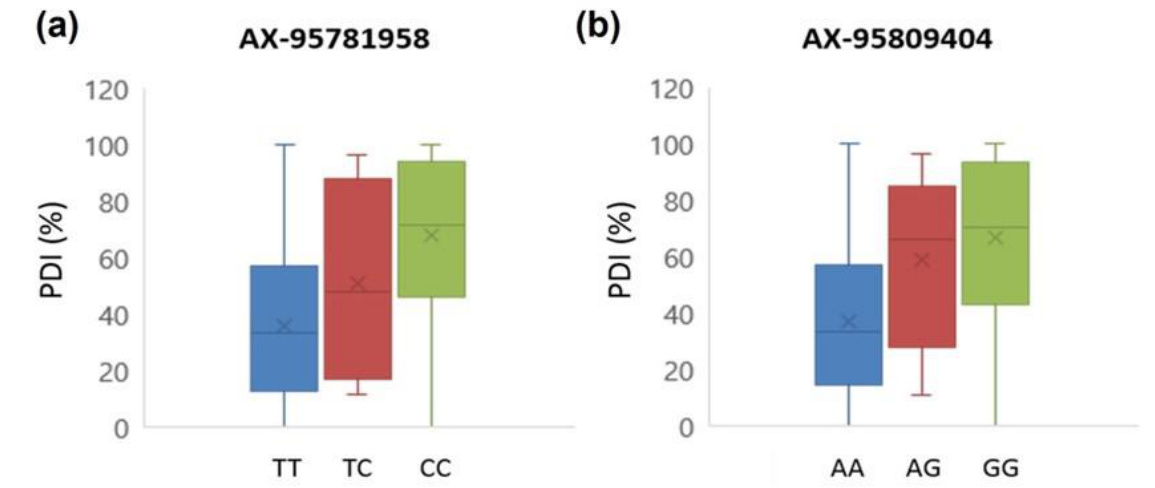
Figure 7. Box plots showing phenotypic distribution of the different genotypes of the SNPs ( a,b ). Blue and green represent the phenotypic distribution for the homozygous genotypes, while red represents that for the heterozygous genotype.